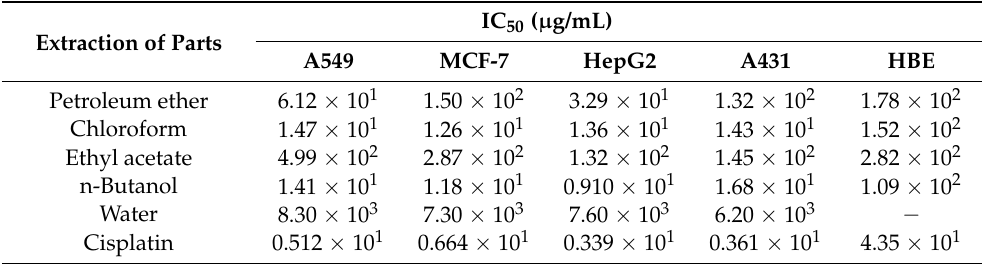
Table 2. Cytotoxicities of different fractions from